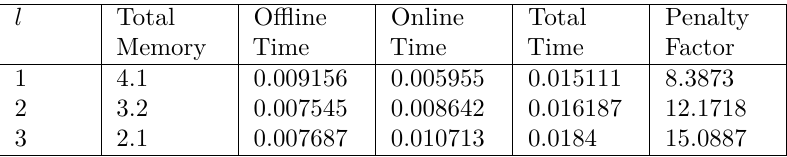
Table 6: Second-order masked S-box compression using the table-based scheme with pre- processing (see Algorithm 6). Total memory required for PRESENT in KB and execution times are in